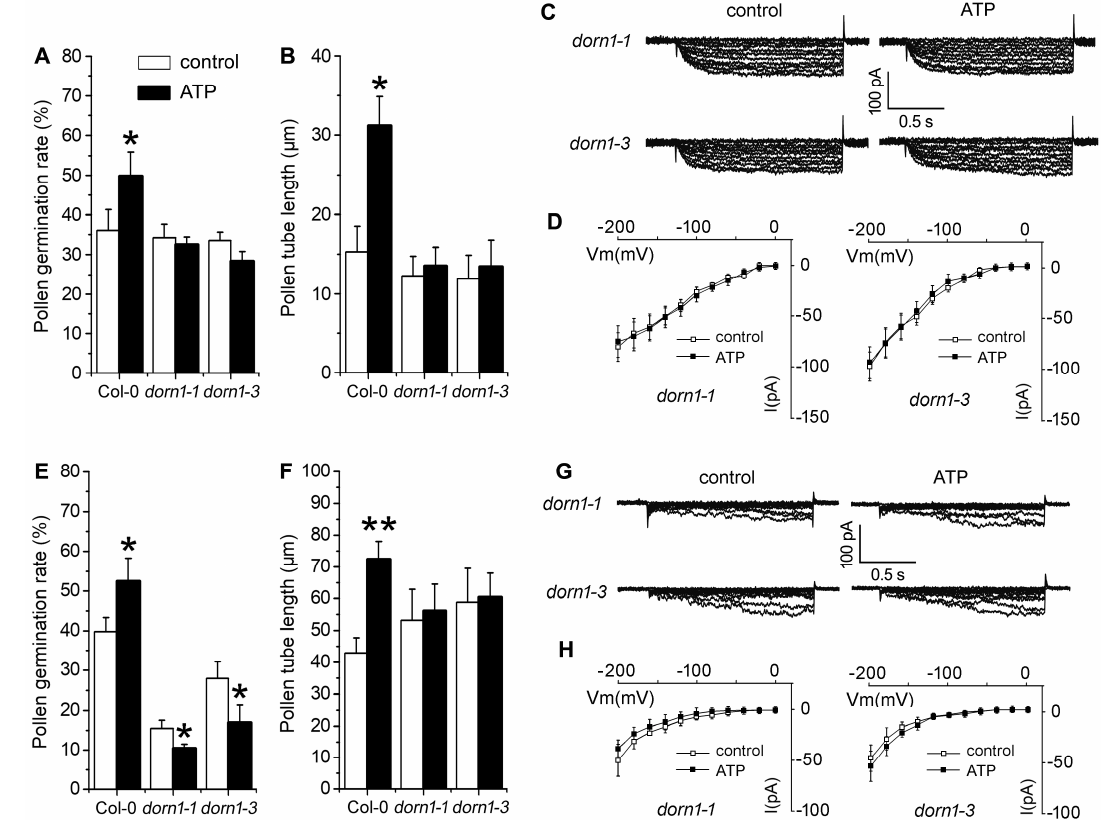
Figure 6. P2K1 receptor (DORN1) is involved in the eATP-regulated PG, PTG, and ion influx. Two DORN1 null mutants ( dorn1-1 , dorn1-3 ) were used. ( A – D ) show the effects of ATP on PG ( A ) and PTG ( B ) in medium containing 0.1 mM KCl and the corresponding K + influx current traces ( C ) and I-V relationship curves (( D ), n = 7). ( E – H ) show the effect of ATP on PG ( E ) and PTG ( F ) in medium containing 0.1 mM CaCl 2 and the corresponding Ca 2+ influx current traces ( G ) and I-V relationship curves (( H ), n = 7). In the pollen germination experiment, at least 300 pollen grains or 150 pollen were counted or measured; data from 3 replicates were combined to obtain the mean ± SD. Student’s t test p values: * p < 0.05, ** p < 0.01. In the patch clamp experiment, data from 7 pollen protoplasts were recorded and combined to obtain the mean ± SD.